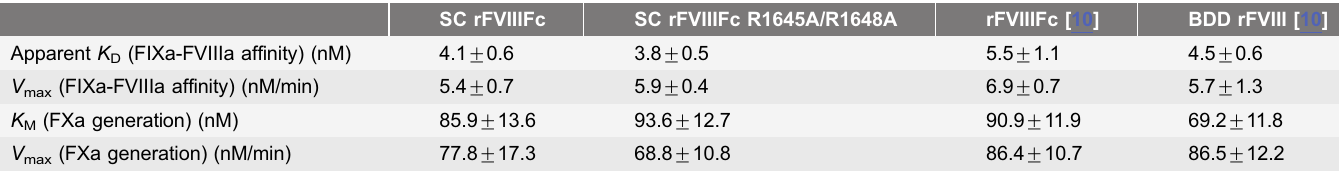
Table 2. Comparison of FIXa binding to FVIIIa within Xase complex and FX interaction with Xase complex assembled with FVIIIa on synthetic phospholipids (n 5 6, Mean ¡ SD) [10].